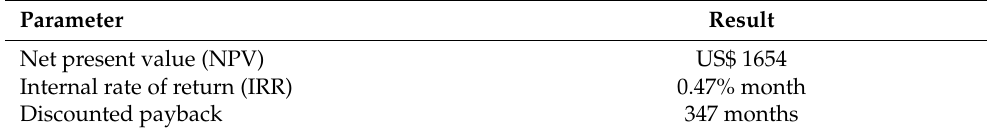
Table 4. Financial analysis results.